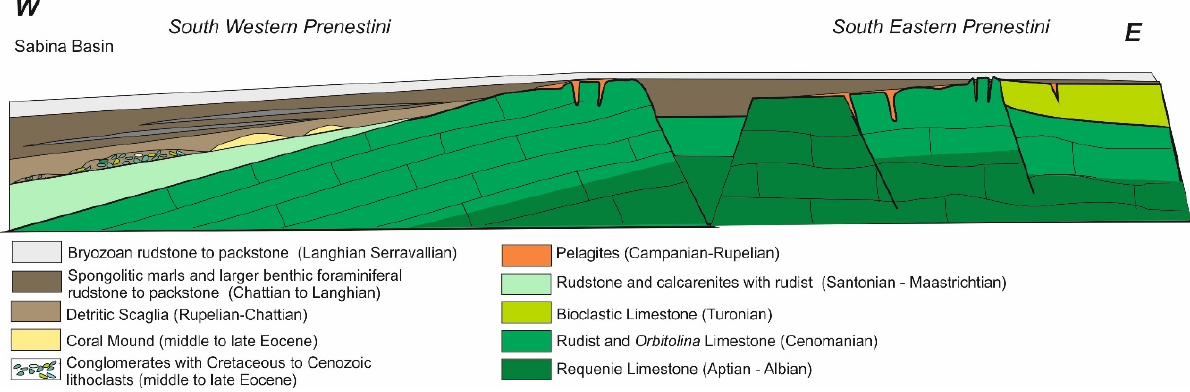
Figure 9. Schematic tectono-stratigraphic architecture of the Prenestini fault-block platforms. See text for details.